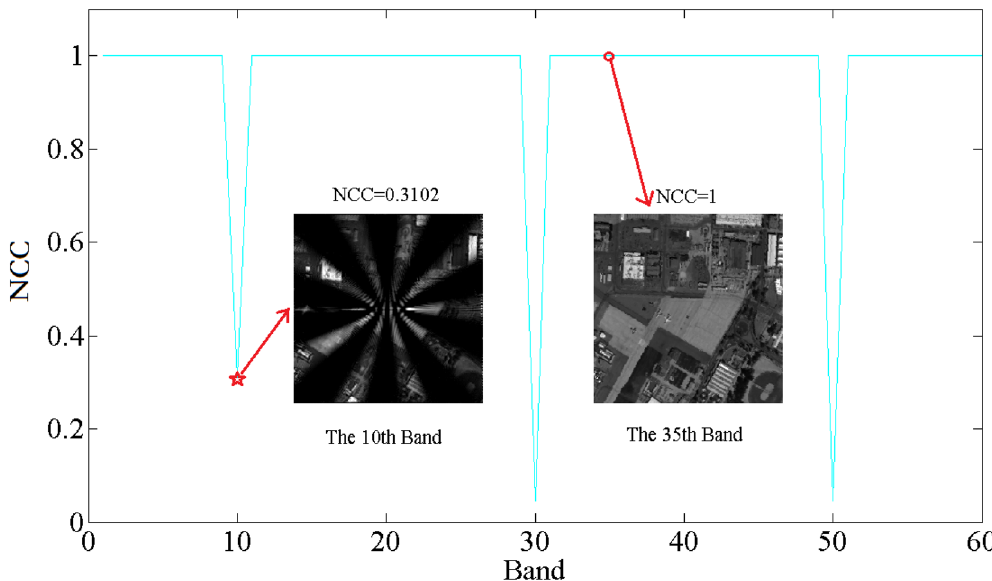
Figure 9. The NCC curve calculated by using the tampered random order p in RSPF.